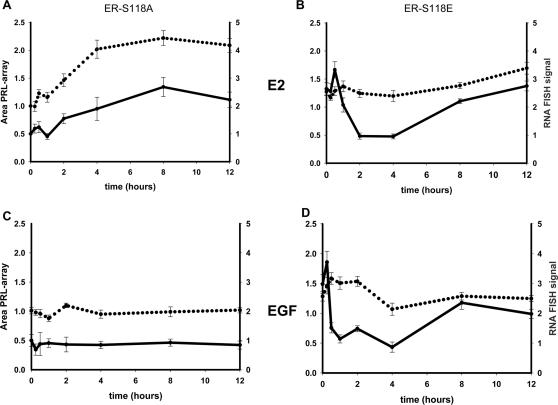
Temporal single-cell analyses of ER-S118A and ER-S118E transcriptional response at the PRL-array.PRL-HeLa cells transiently expressing the two phosphomutants, GFP-ERS118A (panel A and C) or GFP-ERS118E (panel B and D), were treated with either ethanol, E2 (panel A and B) or EGF (panel C and D) for different times. Subsequent to ligand treatment, the cells were fixed and subjected to RNA FISH using a biotinylated dsRED2 probe followed by fluorescent-tagged streptavidin. The FISH signal at the array was determined as described and the value graphed as fold induction over vehicle control cells (solid line). For each cell the area of the array was also determined and plotted as fold induction over vehicle control (dotted line). Data represent the mean ±SEM of three different experiments graphed as fold induction over time-matched vehicle-treated control cells.